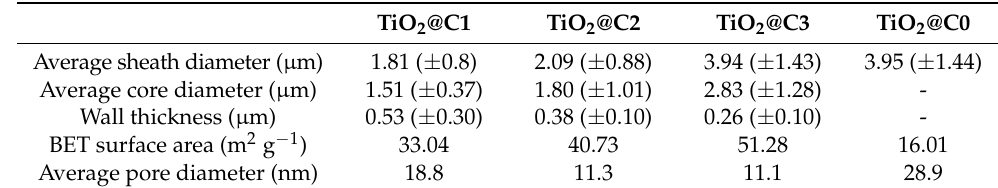
Table 2. Physical properties of TiO 2 @C1, TiO 2 @C2, TiO 2 @C3, and TiO 2